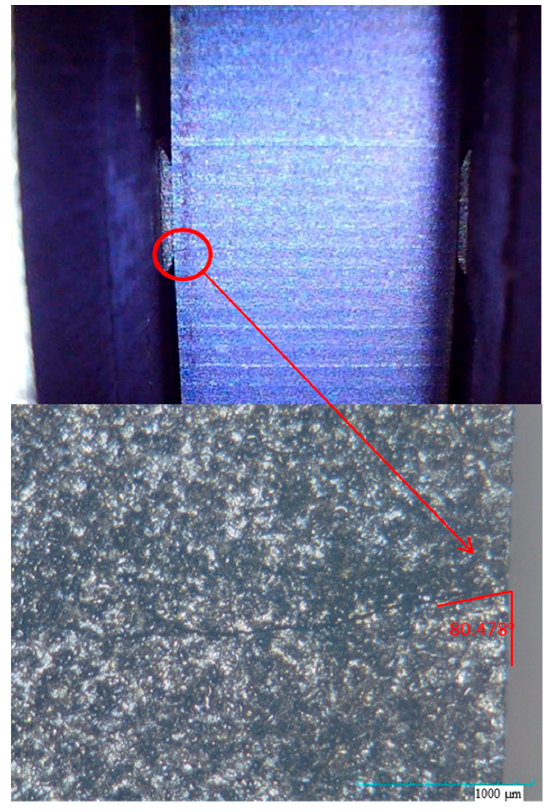
Figure 9. Image of the orientation of the crack initiation of Series 2.